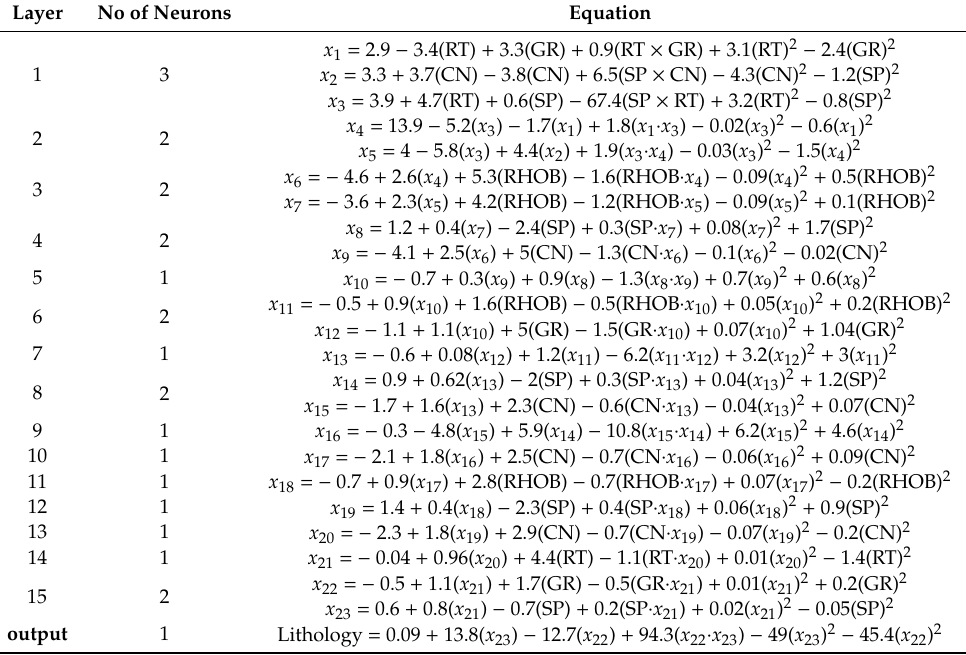
Table 6. Network structure and equations from GMDH lithology classifier.